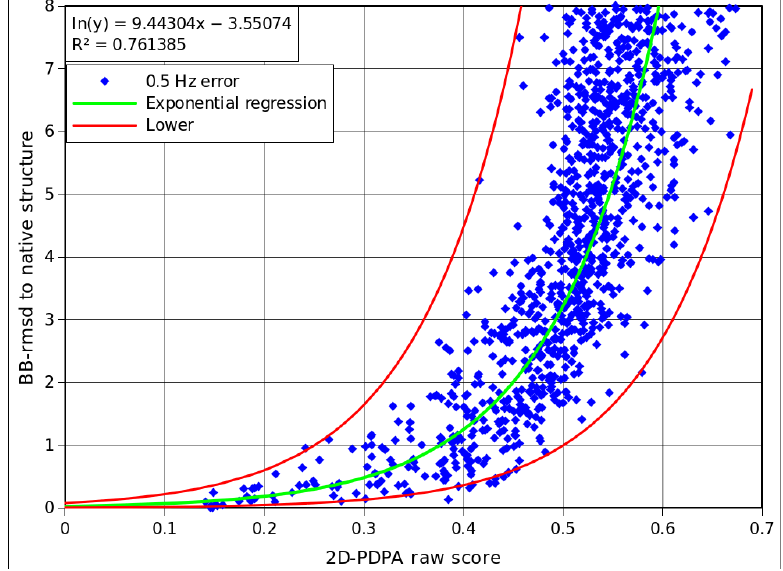
Figure 9. Sensitivity of 2D-PDPA analysis as a function of bb-rmsd when applied to the protein 1A1Z (83 residues).